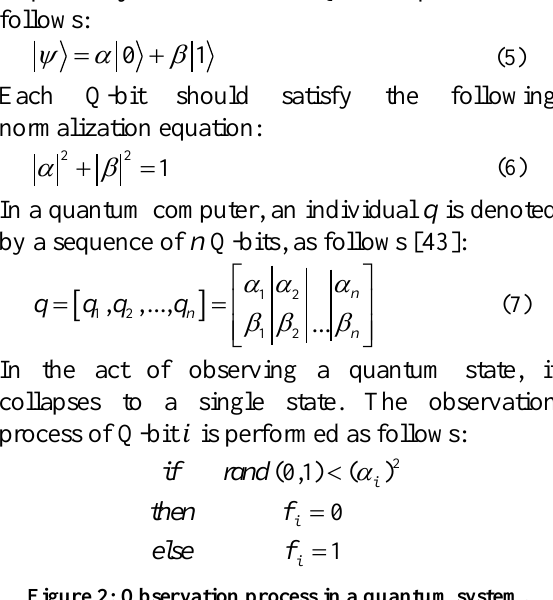
Figure 2: Observation process in a quantum